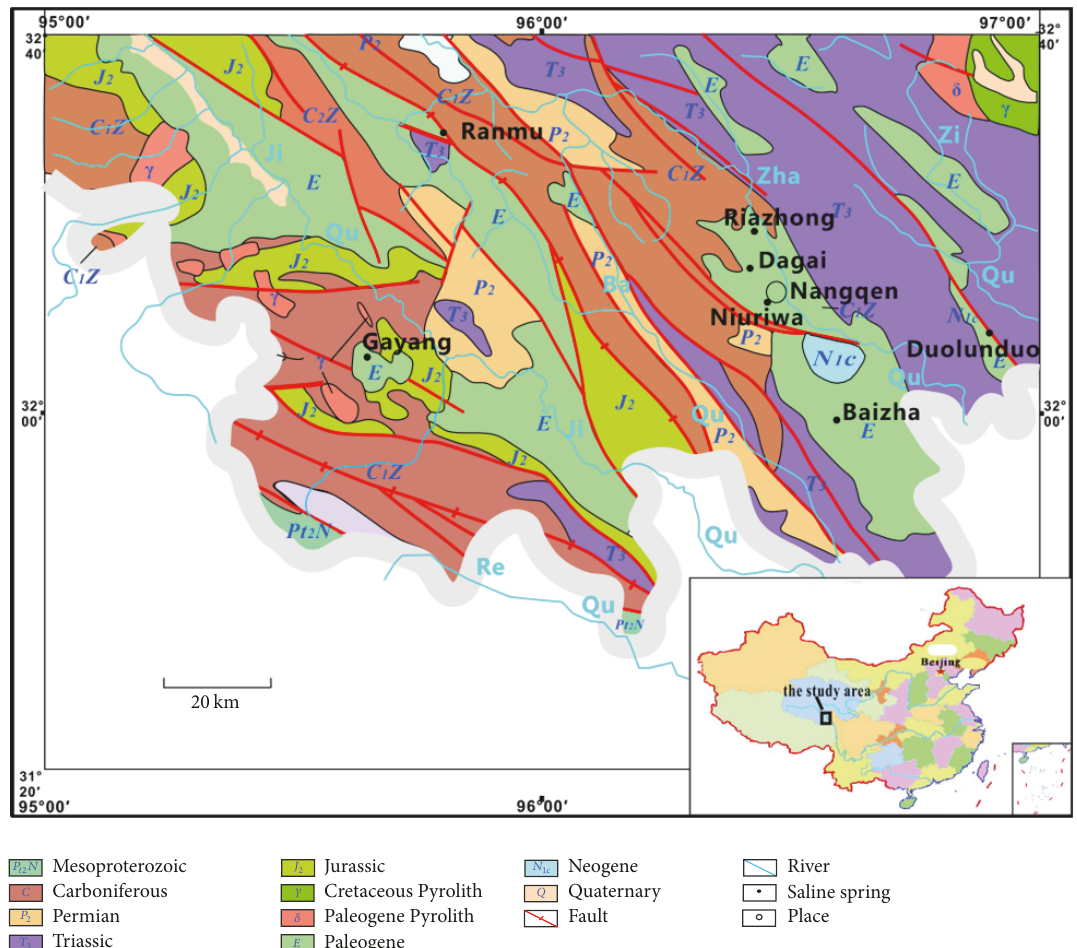
Figure 1: Simplified geologic map of the Nangqen Basin (modified after Han et al. [8]).